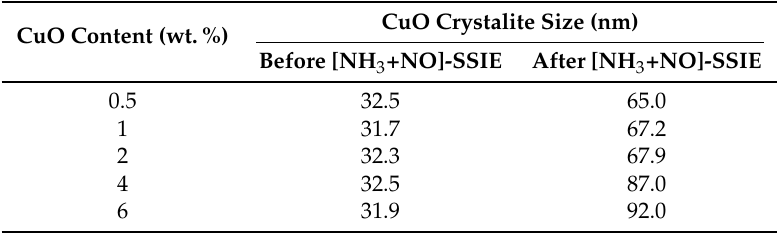
Table 1. Calculated crystal size of CuO before and after [NH 3 +NO]-SSIE based on XRD measurements and analysis using the Scherrer equation of physical mixtures of CuO and H-SSZ-13. CuO Crystalite Size (nm) CuO Content (wt.%) Before [NH 3 +NO]-SSIE After [NH 3 +NO]-SSIE